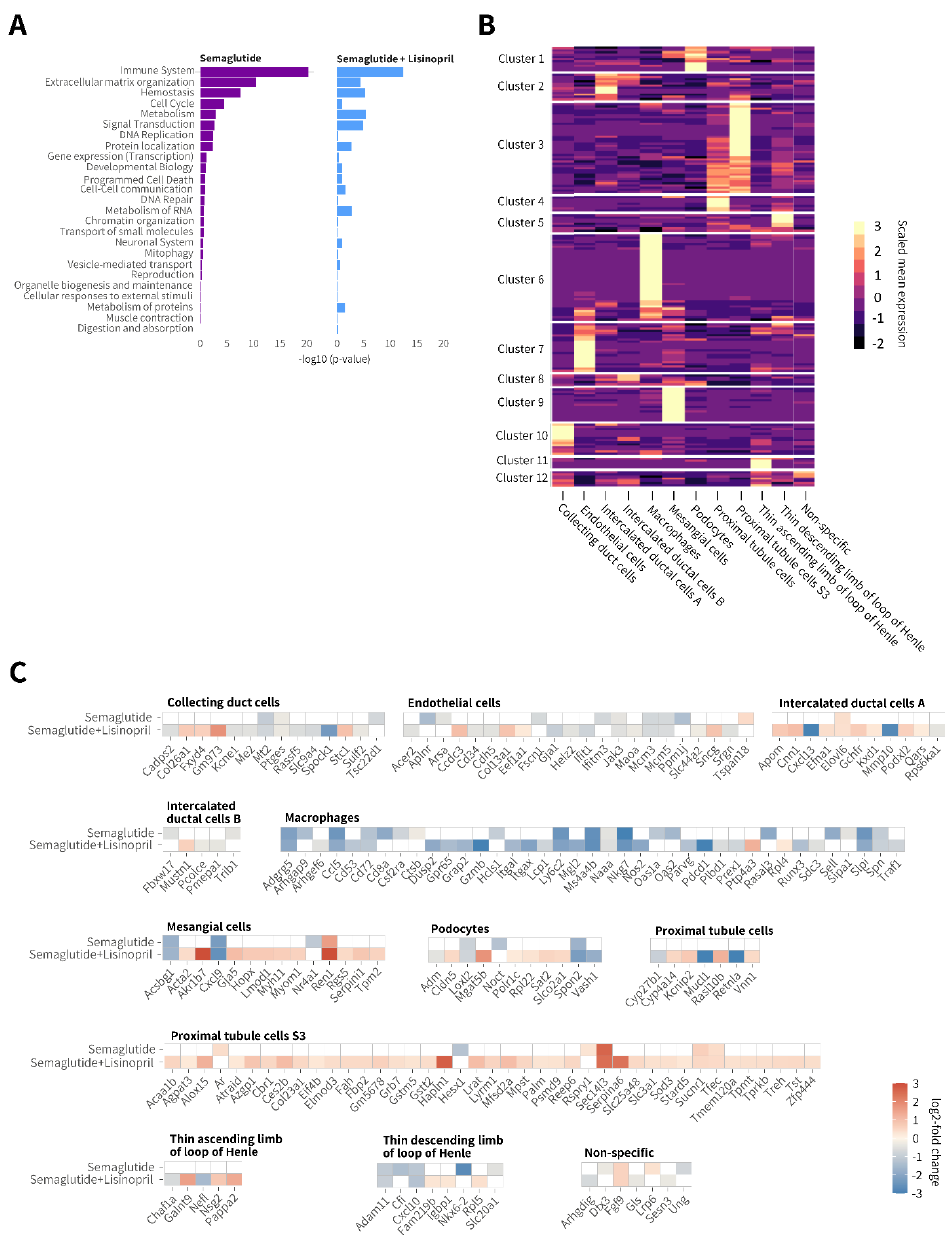
Figure 7. Semaglutide suppresses gene expression markers of extracellular matrix remodelling and immune system activation in db / db UNx-ReninAAV mice. ( A ) Enriched Reactome pathways following semaglutide (30 nmol/kg, s.c., q.d. n = 7) and semaglutide (30 nmol/kg, s.c., q.d.) + lisinopril (30 mg/kg, p.o., n = 7) treatment compared to corresponding vehicle-dosed db / db UNx- ReninAAV mice ( n = 7). ( B ) Deconvolution of differentially expressed genes (DEGs) according to major kidney cell type. Bright yellow color in heatmap denotes cluster of genes expressed with relative high cell specificity. ( C ) Heatmaps illustrating expression changes in individual DEGs grouped according to major cell type expressing the corresponding gene. Data are expressed relative to vehicle-dosed controls. Color gradients indicate significantly upregulated (red color) or downregulated (blue color) gene expression (log2-fold change, false discovery rate (FDR) < 0.05). All DEGs are listed in Table S1. Bulk RNA sequencing data are accessible using a web-based global gene expression data view-er [Gubra Gene Expression Experience (GGEX), https://rnaseq.gubra.dk/, accessed on 3 July